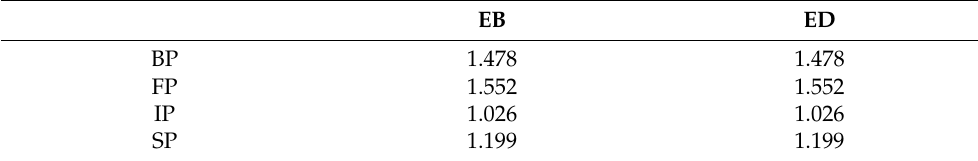
Table 6. Inner VIF values.